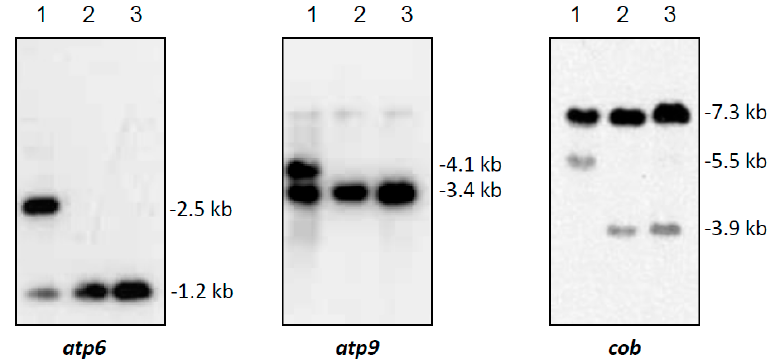
Figure 2. Southern hybridization pattern of mtDNA digested with Hind III using the mitochondrial genes atp6 , atp9 and cob as probes. Lanes: 1, CMS PET2 (male sterile); 2, CMS PET1; 3, HA89 (fertile, normal cytoplasm).